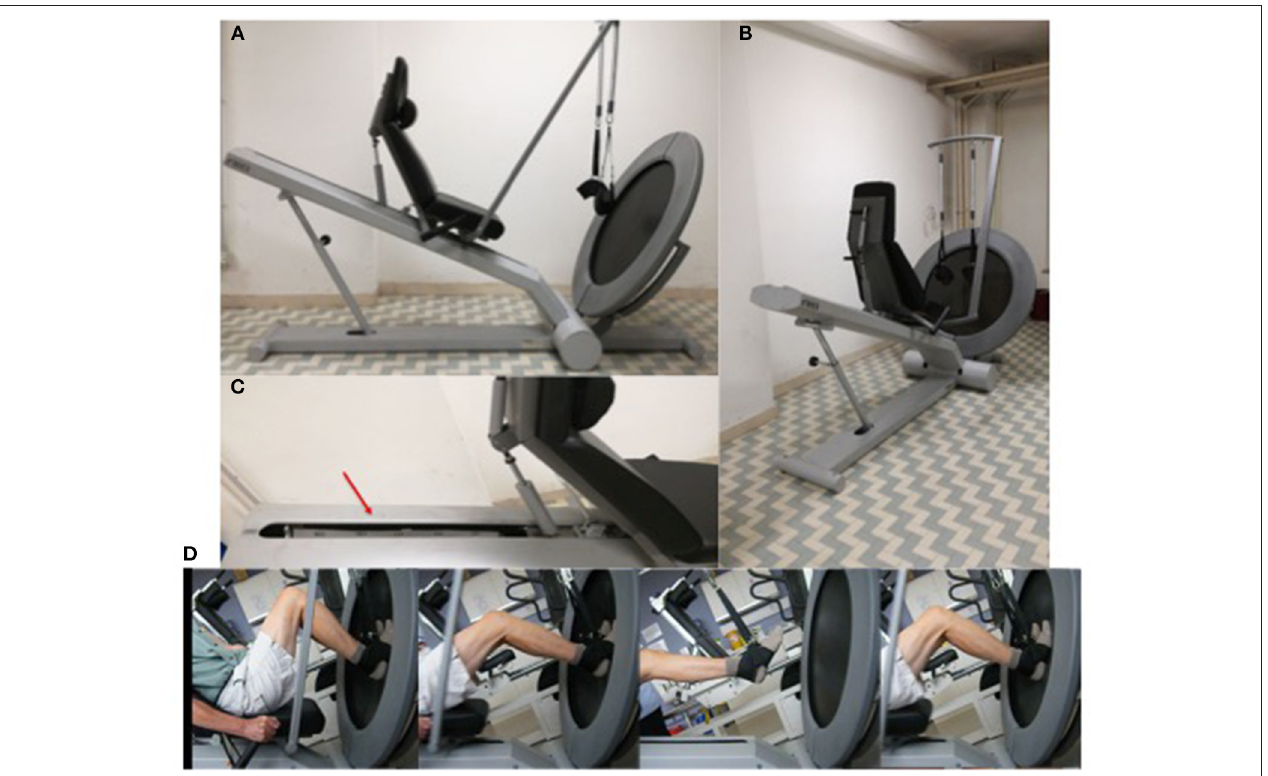
FIGURE 1 | (A,B) Trampoline Trainer exercise device. (C) The red arrow points to the meter scale applied to the rail track of the TT device. (D) Representation of a bounce sequence performed by an elderly